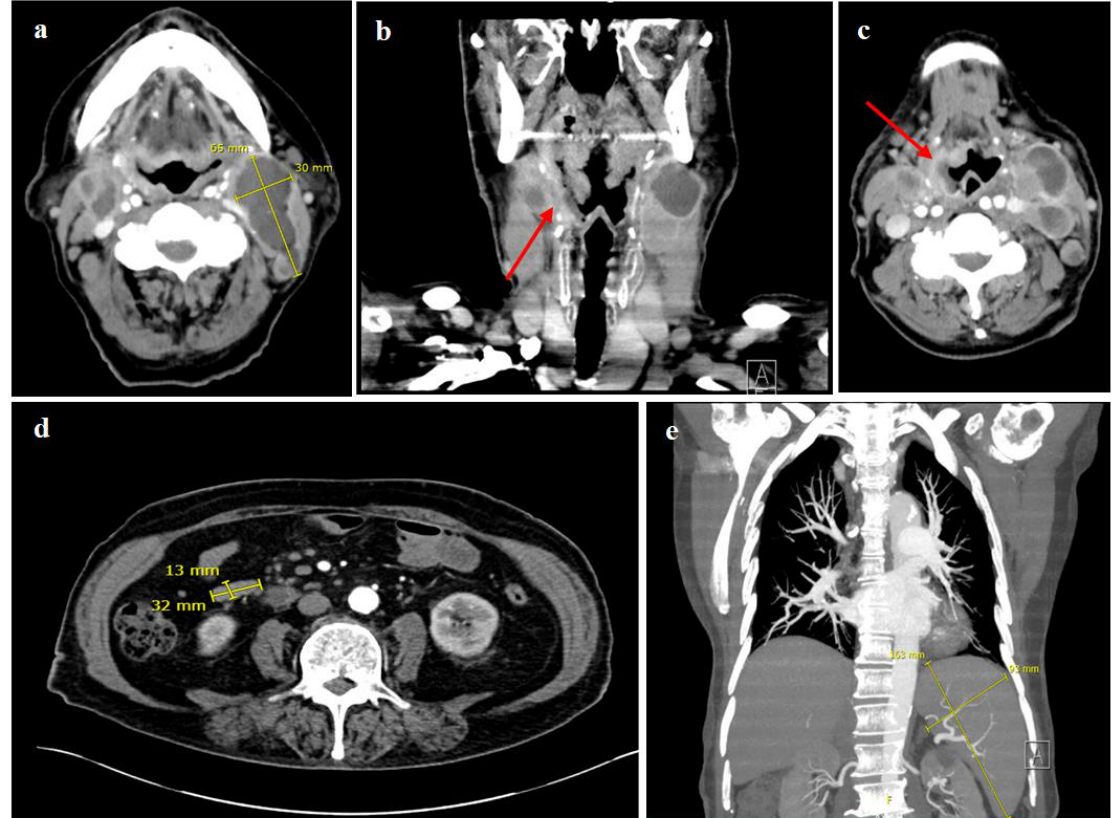
reaching from the dorsolateral right side of the tongue, over the right oro- and hypopharynx up to